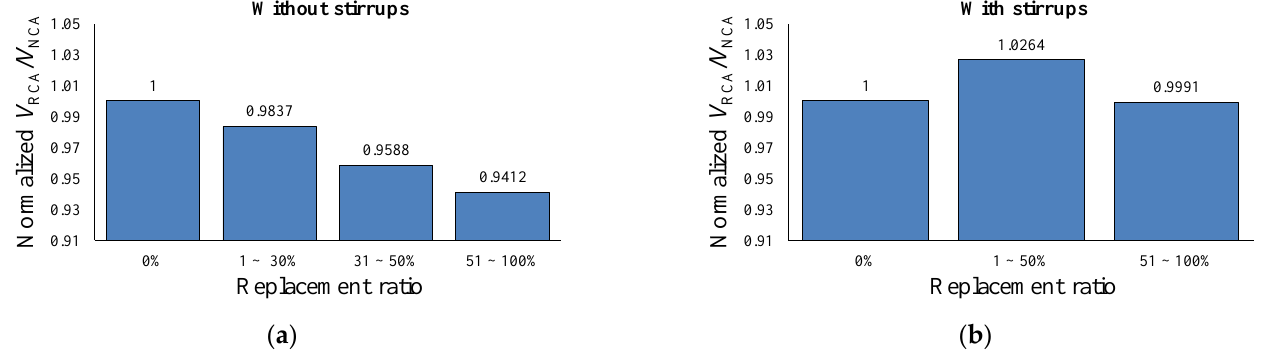
Figure 6. Average normalized ratio for each group. ( a ) Specimens without shear reinforcement. ( b ) Specimens with shear reinforcement.